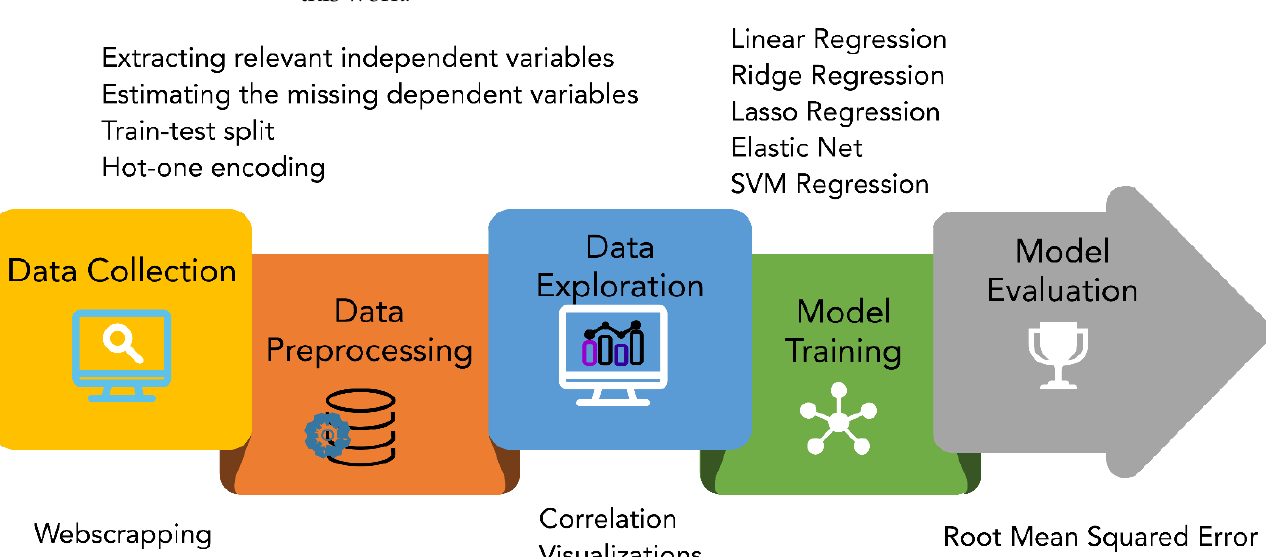
Figure 1. Flowchart of regression process.